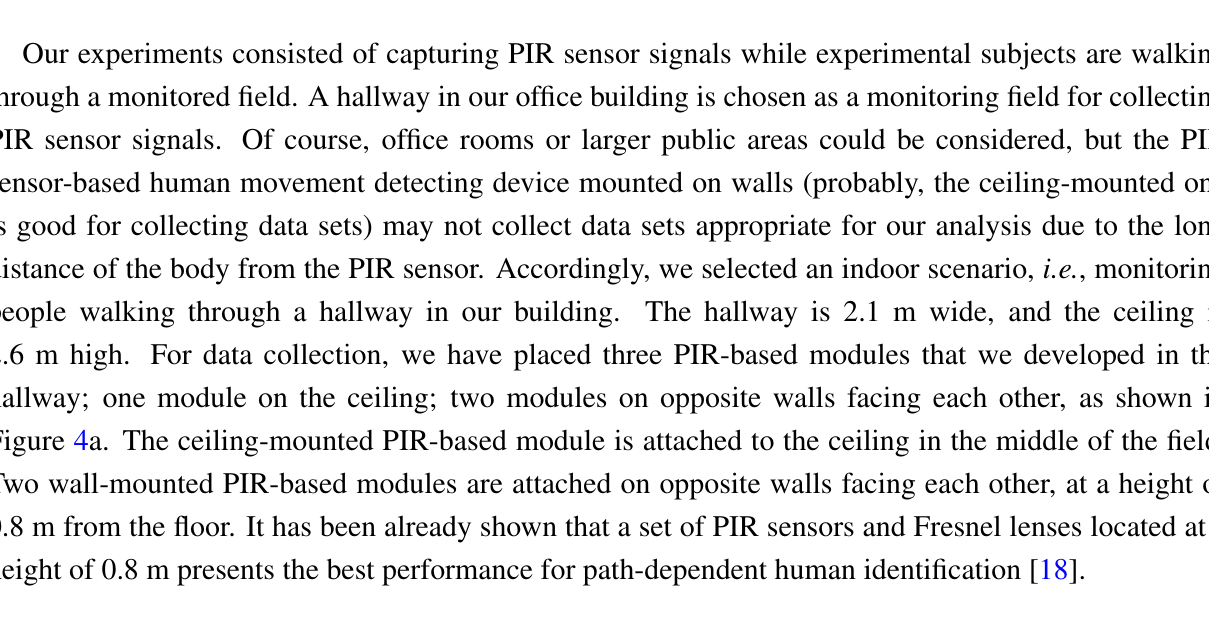
Figure 4. Experimental setup for data collection while an experimental subject is walking, ( a ) a front view of the monitored field; ( b ) a top view of the monitored